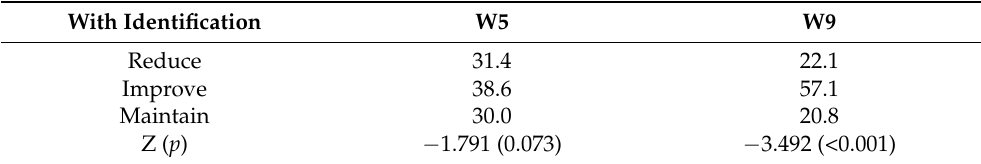
Table 3. Variation of the hedonic appreciation of anonymous and identified samples with age at weaning (5 or 9 months). Results are expressed in the percentage of responses in the indicated direction. With Identification W5 W9